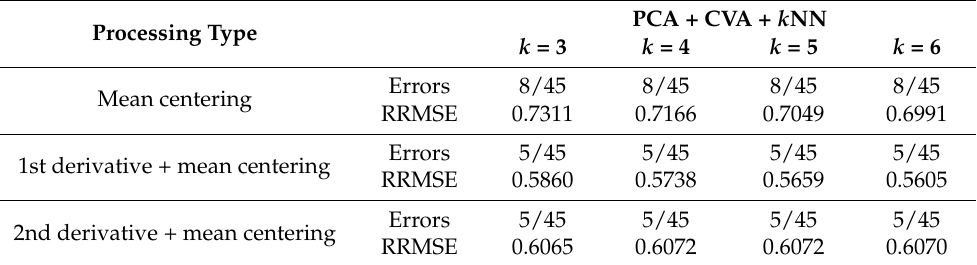
Table 11. Study No. 3 with MIR Spectral Data. Prediction-Set Classification Errors (45 Samples).